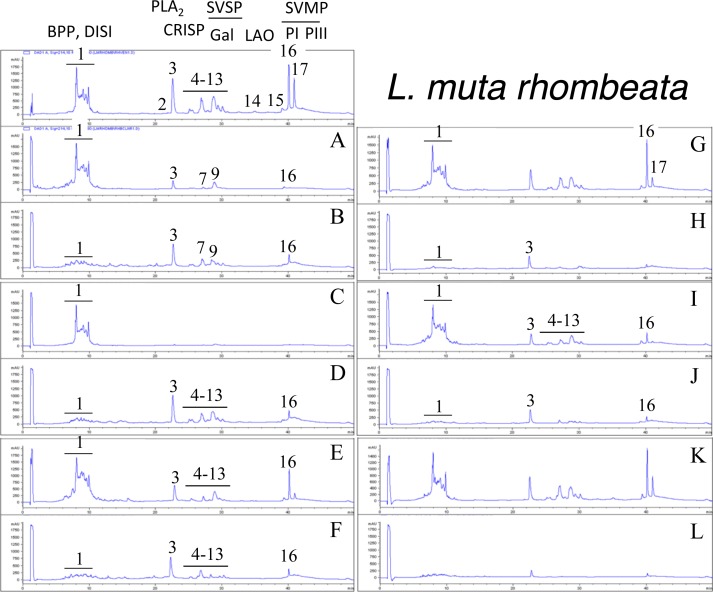
Immunoaffinity chromatography-based antivenomic analysis of the immunoreactivity of polyspecific and monospecific antivenoms towards the venom of L. muta rhombeata from Brazil.Panels display reverse-phase separations of whole venom components, and non-retained (A, C, E, G, and I) and the retained (B, D, F, H, and J) fractions recovered, respectively, from the affinity columns of immobilized BCL, BL, AL, AB, and AC antivenoms. Panels K and L, non-retained and retained venom fractions by immobilized equine control immunoglobulins. CRISP, cysteine-rich secretory protein; other acronyms as in the legend of Fig 2.